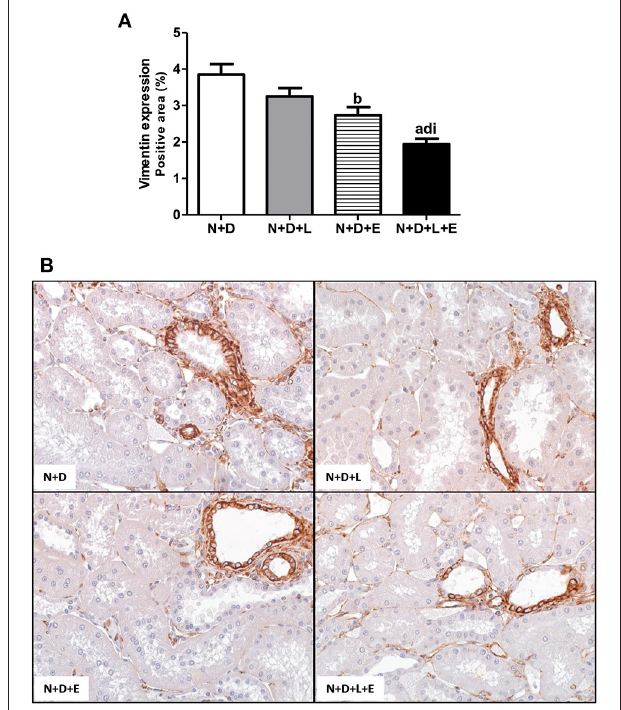
FIGURE 8 | Immunohistochemical analysis of α -smooth muscle actin ( α -SMA) expression in the renal cortex. (A) Bar graph of α -SMA expression evaluated 60 days after 5/6 nephrectomy in vitamin D-deficient rats treated with losartan, erlotinib or losartan + erlotinib. (B) Representative photomicrographs of immunostaining for α -SMA in the renal cortex from a N + D, N + D + L, N + D + E and N + D + L + E rat (x400). Note that α -SMA expression is significantly lower in the N + D + L + E than in the other groups. Data are mean ± SEM. a p < 0.001 vs. N + D; d p < 0.001 vs. N + D + L; g p < 0.001 vs. N + D + E. N, 5/6-nephrectomized rats; D, vitamin D-deficient rats; L, losartan-treated rats; E, erlotinib-treated rats; L + E, rats concomitantly treated with losartan + erlotinib. N + D ( n = 10); N + D + L ( n = 8); N + D + E ( n = 7); N + D + L + E ( n = 10).